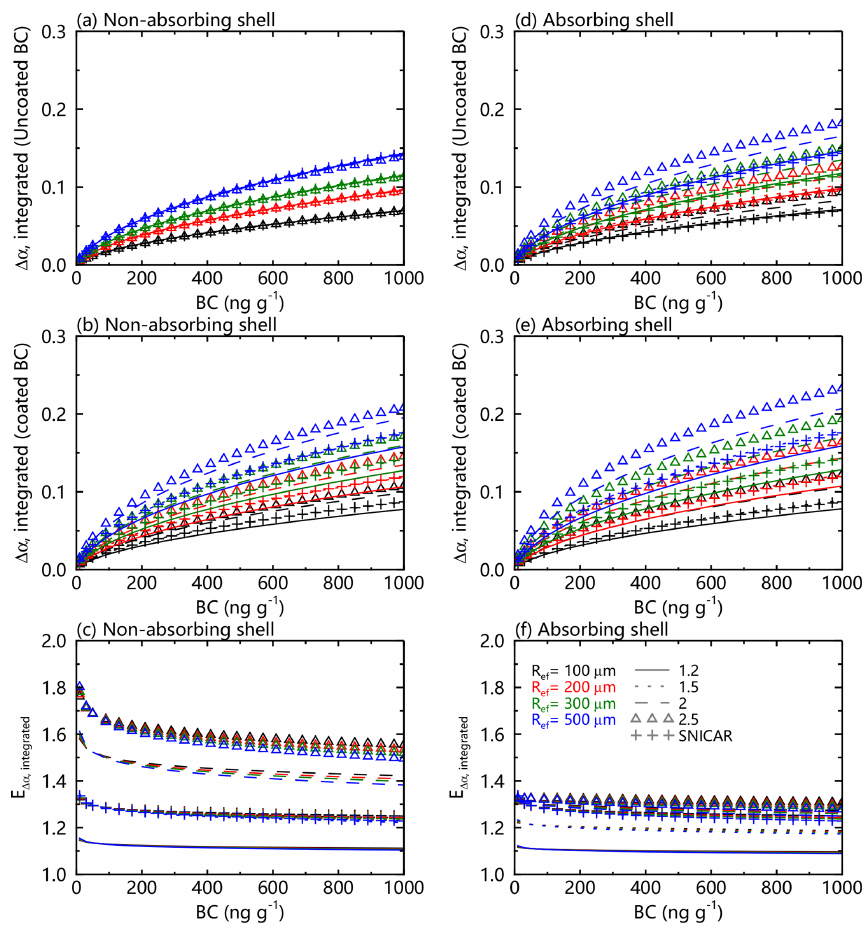
Figure 7. Same as Fig. 5, but for the snow albedo reduction ( (cid:49)α integrated